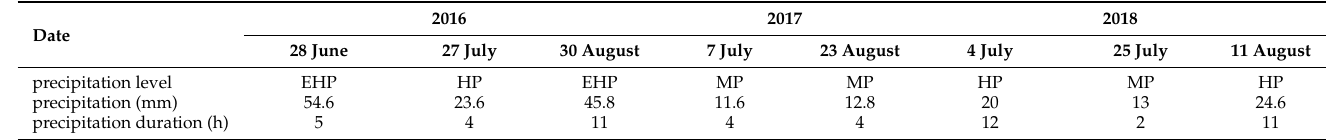
Figure 5. Irrigation, precipitation, and ET 0 in the growth period of 2016, 2017, and 2018. The amount of water applied to the field and the flow rate of the drip irrigation system of each treatment were monitored daily, separately, through independent water meters and valves. Precipitation data were obtained from an on-site weather station (HOBO U30 Onset). Table 3. Precipitation and precipitation classification at different